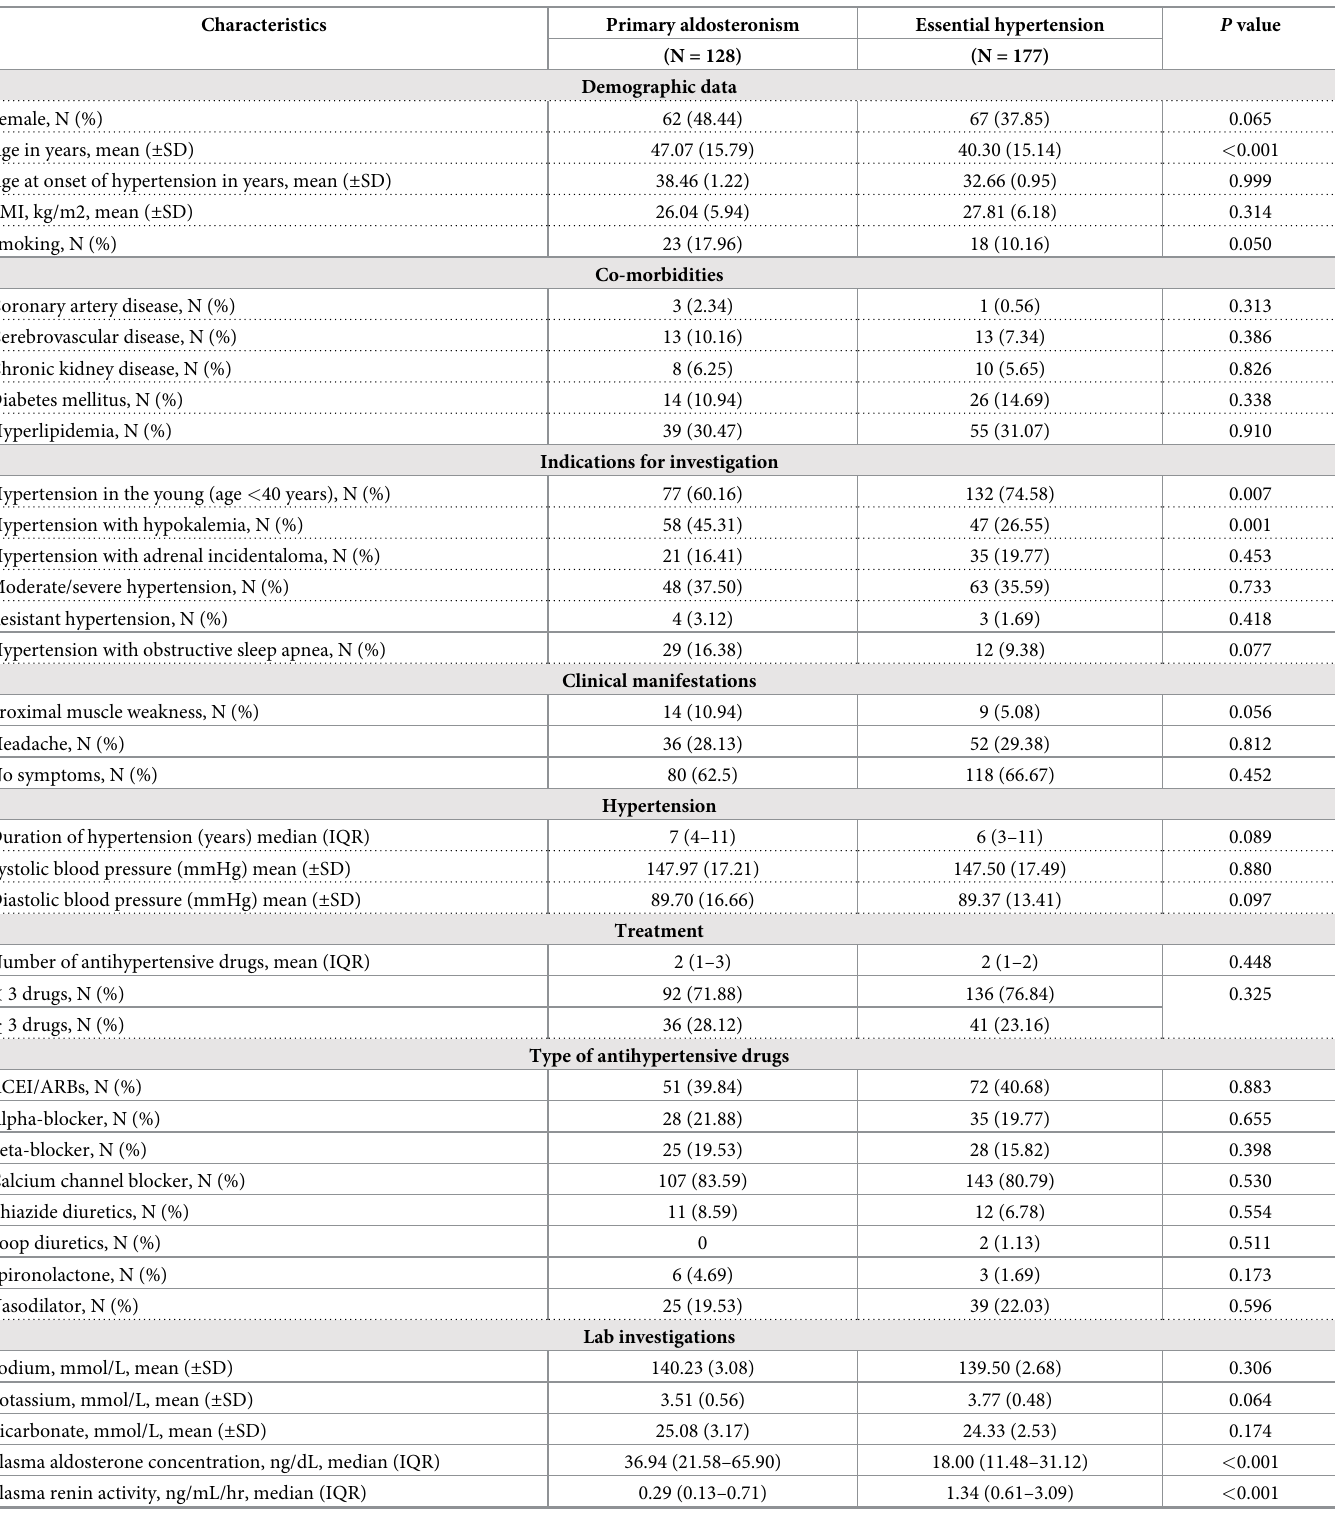
Table 1. Baseline characteristics of